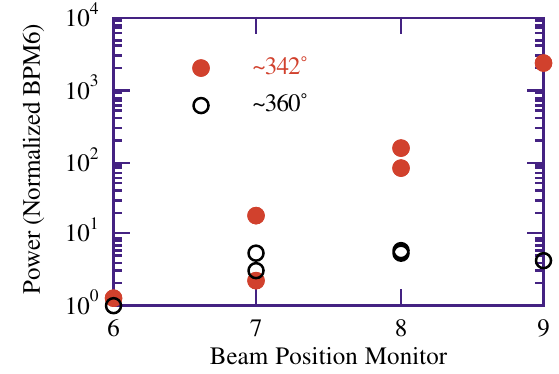
FIG. 13. (Color) Spectral peak power as a function of BPM position for two different betatron phase